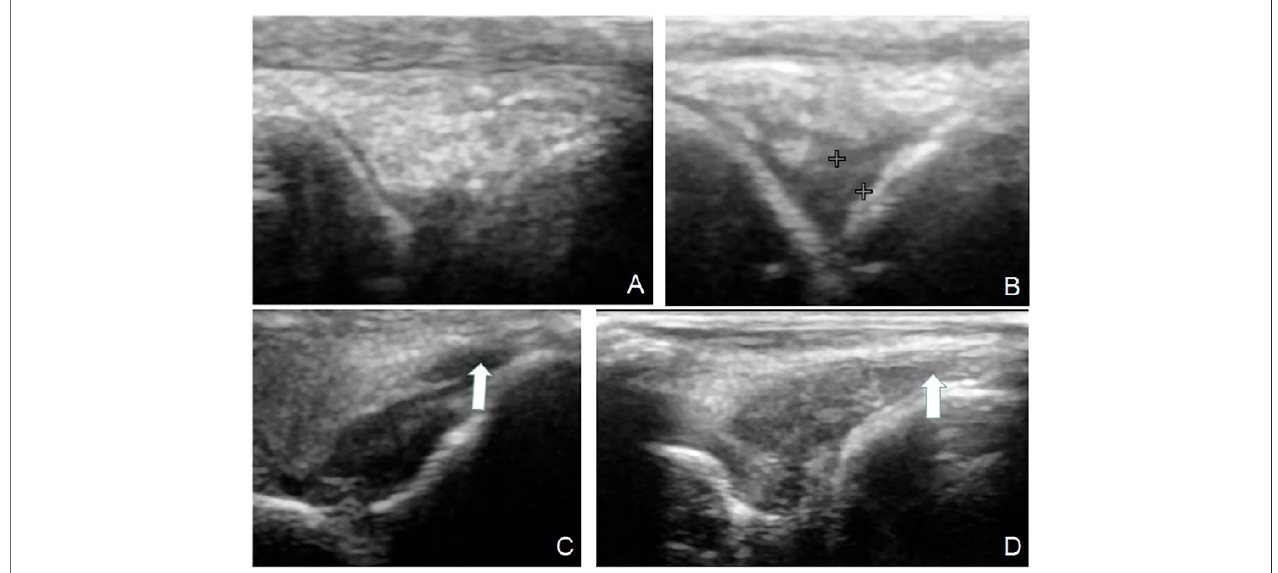
FIGURE5| Ultrasonicevaluationofsynovitis.Score0:noobviousthickeningofsynovium.(TP-SLNgroup, (A) );score1:mildsynovitiscanbeseen(++),butitdoes not exceed the line of the highest point on the bone surface (TP group, (B) ). Score 2: the line is higher than the highest point of bone surface, but not higher than the backbone (DMSO group, (C) ). Score 3: over the line of the highest point of the bone surface and extending over one side of the shaft (control group, (D) ).